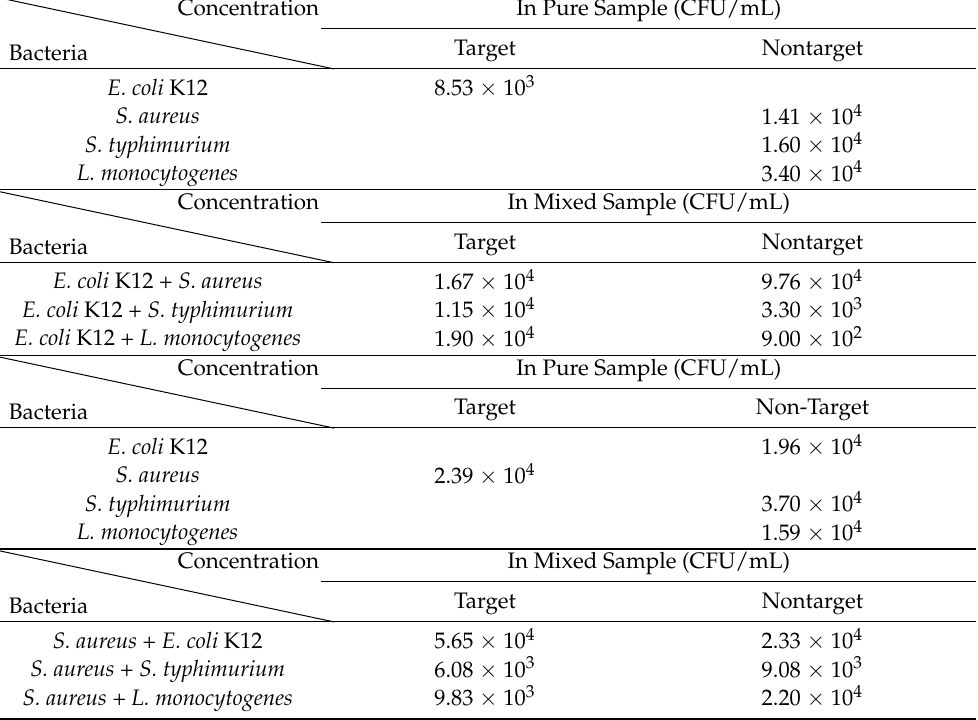
Table 1. Concentrations of each bacterium in pure and in mixed samples when E. coli MEI sensor (top) and S. aureus MEI sensor (bottom) were tested for specific and selective